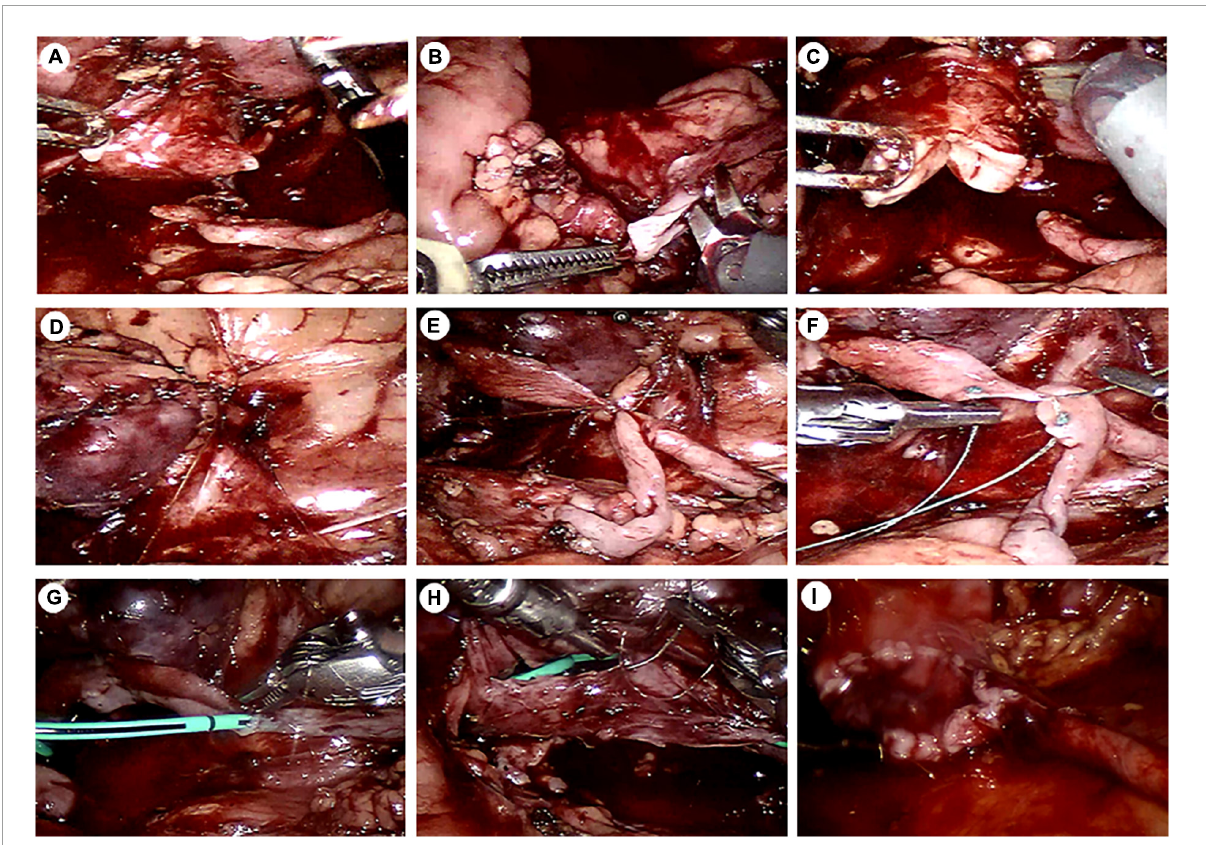
FIGURE3 Intraoperative images. (A) The ureteropelvic junction was dismembered. (B) The ureter was cut longitudinally along the lateral edge of the ureter. (C) The renal pelvis was cut into double flaps. (D) The inferior pole of the kidney was fixed to the lateral abdominal wall. (E) The first stitch was placed between the lowest point of the inferior and the lowest point of the spatulate ureter. (F) The posterior wall was sutured continuously a using a traction suture. (G) A DJ stent was placed. (H) The anterior wall was anastomosed continuously. (I) The superior pelvis flap was sutured. Finally, the pelvis and the ureter together formed a